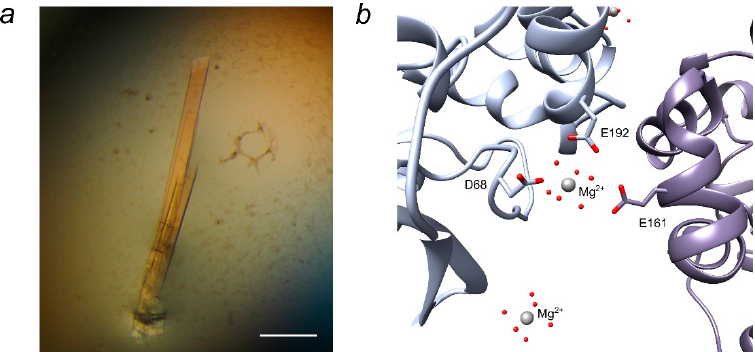
Figure 2. LinB D147C+L177C crystals and crystal contacts. ( a ) Rod-like crystals of LinB 147C+L177C from condition #53 of PEGs Suite, the scale bar is 200 µm; ( b ) Mg 2+ ion participating in crystal contact via its hydration shell. The view is created by UCSF Chimera version 1.11.2 [23] and PyMOL Molecular Graphics System, Version 1.8 [24]. Int. J. Mol. Sci. 2021 , 22 , x FOR PEER REVIEW LinB D147C+L177C crystals belong to P 2 1 2 1 2 1 space group with one protein molecule